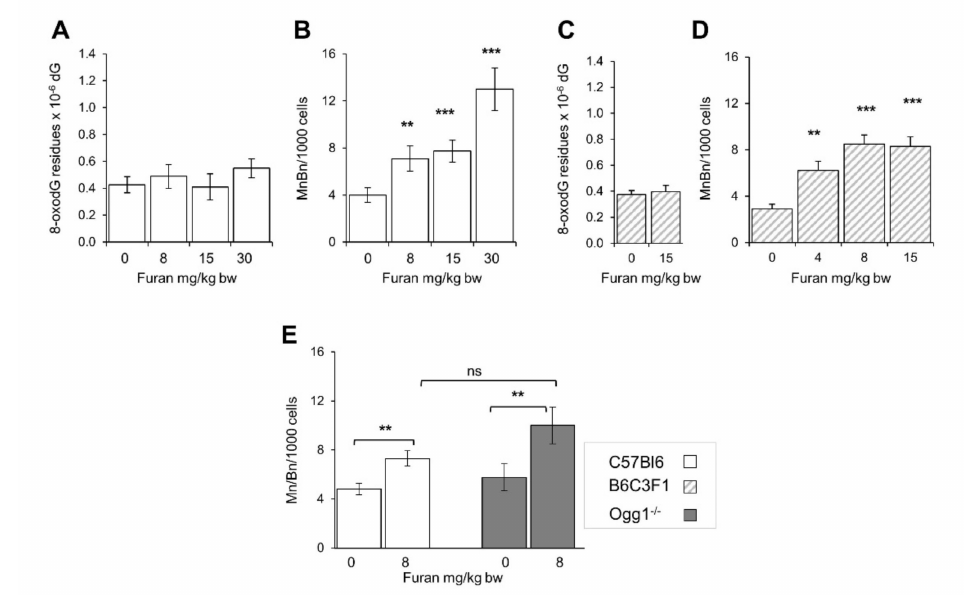
Figure 8. Induction of micronucleated binucleated cells and DNA 8-oxodG in the spleen of C57Bl6 and B6C3F1 following a 28-day oral exposure to furan. Frequency of Bin/Min/1000 spleno- cytes induced in C57Bl6 mice following exposure to the indicated furan doses ( A ); Levels of 8- oxodG/residues/10 6 dG in spleen DNA from furan-treated C57Bl6 ( B ) and B6C3F1 mice ( C ); Fre- quency of MnBn/1000 splenocytes in furan treated C57Bl6 mice (hatched bars) are taken from Leopardi et al., 2010 ( D ); Frequency of MnBn/1000 splenocytes in furan treated C57Bl6 mice (open bars) and Ogg1 − / − mice (closed bars) ( E ). All values are mean +/ − SE (5–11 animals/group). Aster- isks indicate significant differences (** p < 0.01, *** p < 0.001 by two-tailed Student’s t -test), ns, not significant; MnBn, Micronucleated